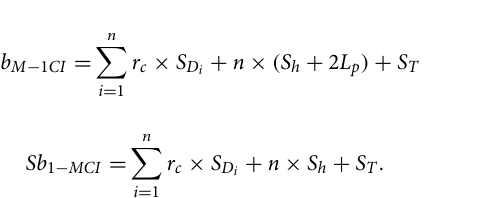
Figure 9. Compression efficiency (data size). We calculate the compression efficiency of 7z when the size of the original data S o gradually increases. Here, r c of 7z is 0.34 when a text file in size of 500 MB is compressed. Given that S T of 7z is 201 KB, we have the results as shown in ( a ) where e c s are calculated for the data storage method in ideal case by e c = 1 − r c = 0.66 and in the self-containment case by e c = 1 − ( r c × S o + 201 K )/ S o . To validate the results, we further pack a set of test data files with different types (e.g., txt, jpg, exe, mp3 ) in a single compressed package and compare their actual values of e c with a fixed r c = 0.34 as shown in ( b ). The results are roughly consistent with those in calculation as shown in ( a